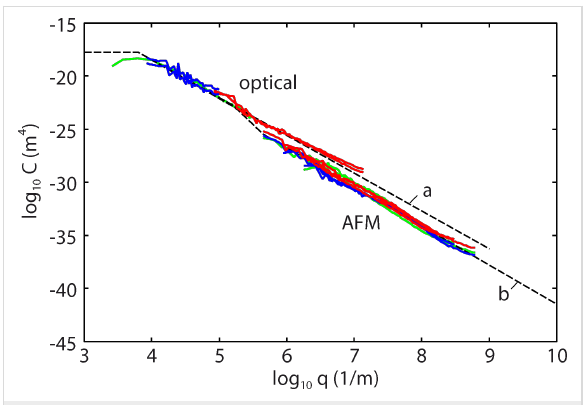
Figure 5: The power spectra as a function of the wave vector (log 10 –log 10 scale). The dashed line denoted by b is the power spectra used in the calculations and correspond to a surface with the surface area A tot = 1.3 A 0 and rms slope 0.9.